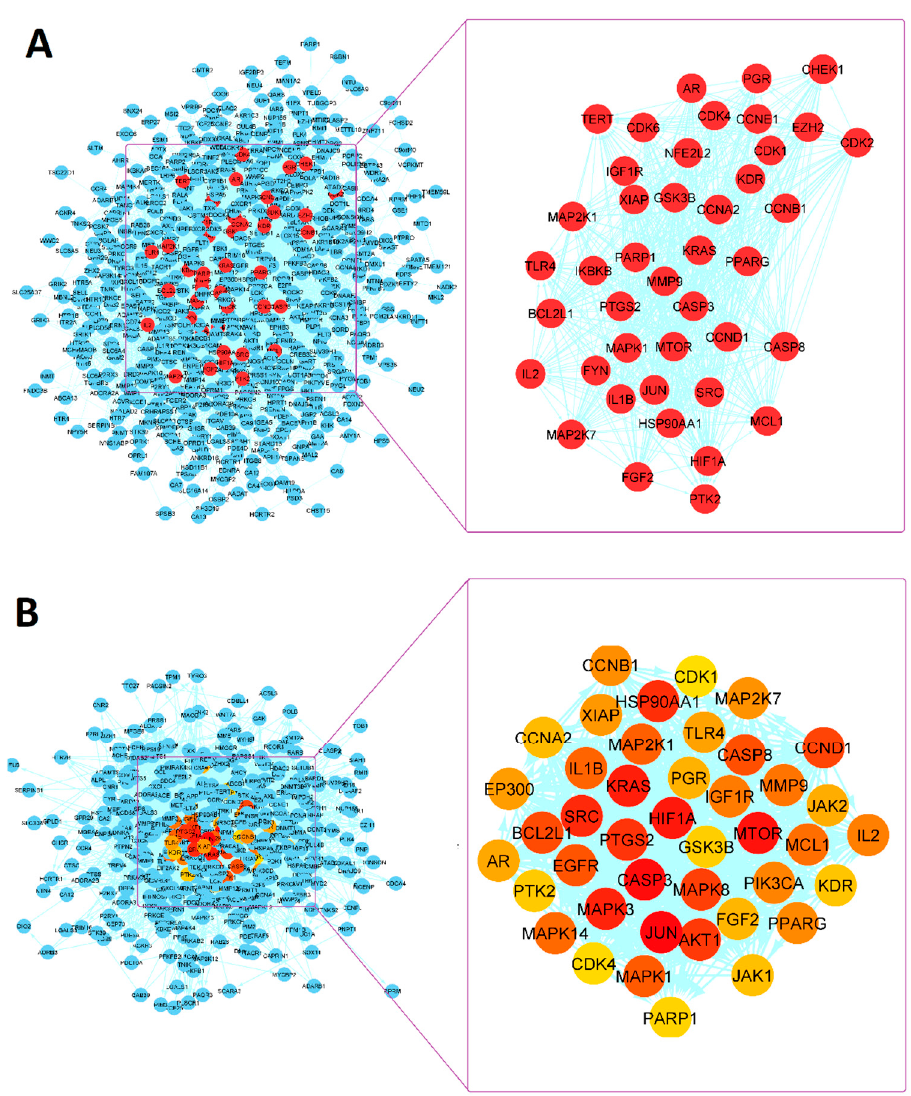
Figure 8. Protein–protein interaction network of common genes of obtained target genes of nominated compounds. A total of 609 target genes were exported to the string database to investigate the interactions between core targets. The PPI network was then developed using Cytoscape as a visualization tool. ( A ) The top protein–protein interacting cluster was constructed to identify the highly interacting nodes that contained 42 nodes (red nodes) and 617 edges. ( B ) Cytoscape-hubba tool was employed to validate the results, generating a network of 42 nodes (colored nodes) and 699 edges.